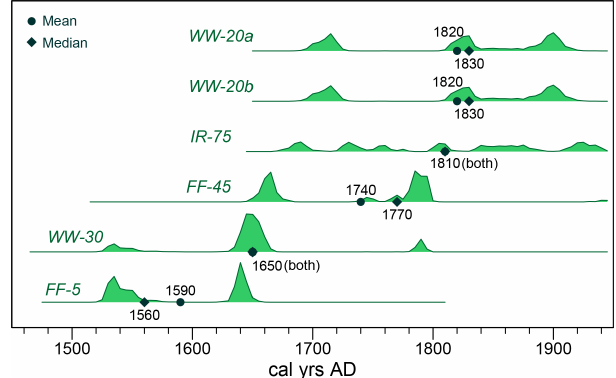
Figure 7. Calibration ranges from the IntCal 20 calibration curve for radiocarbon dates obtained from Winter Wonderland Cave. Sample labels correspond with Table 1. Circles mark the mean cali- brated age for each sample; diamonds denote the median age. Both are labeled in years CE.